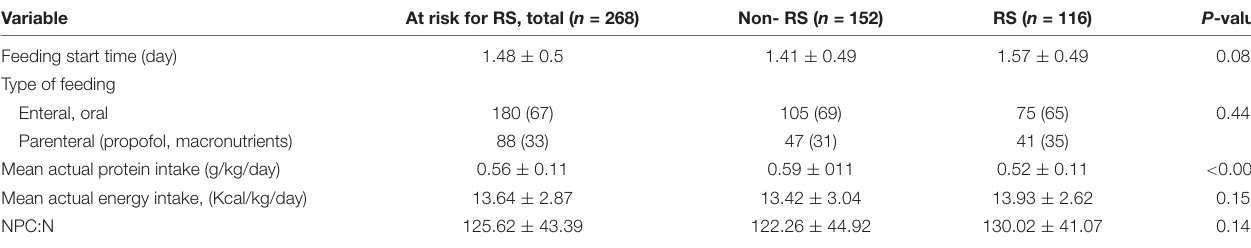
TABLE 2 | Feeding characteristics of at risk patients, stratified by Refeeding syndrome.